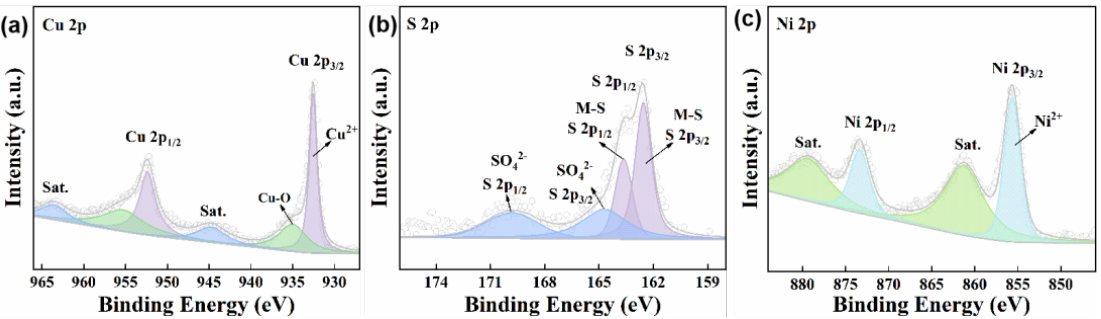
Figure 3. High−resolution XPS spectra of ( a ) Cu 2p, ( b ) S 2p, and ( c ) Ni 2p for Ni 0.1 Cu 0.9 S